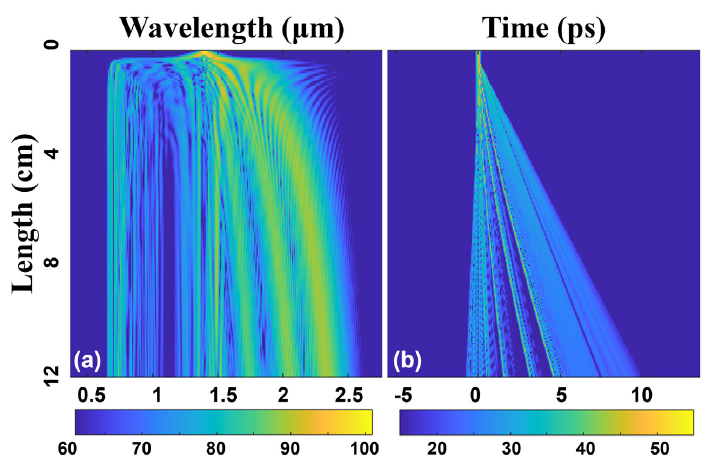
Figure 8. ( a ) Spectral and ( b ) temporal evolutions of the pump pulses with OAM 1,1 mode propagat- ing along the 12 cm optimized RCF.